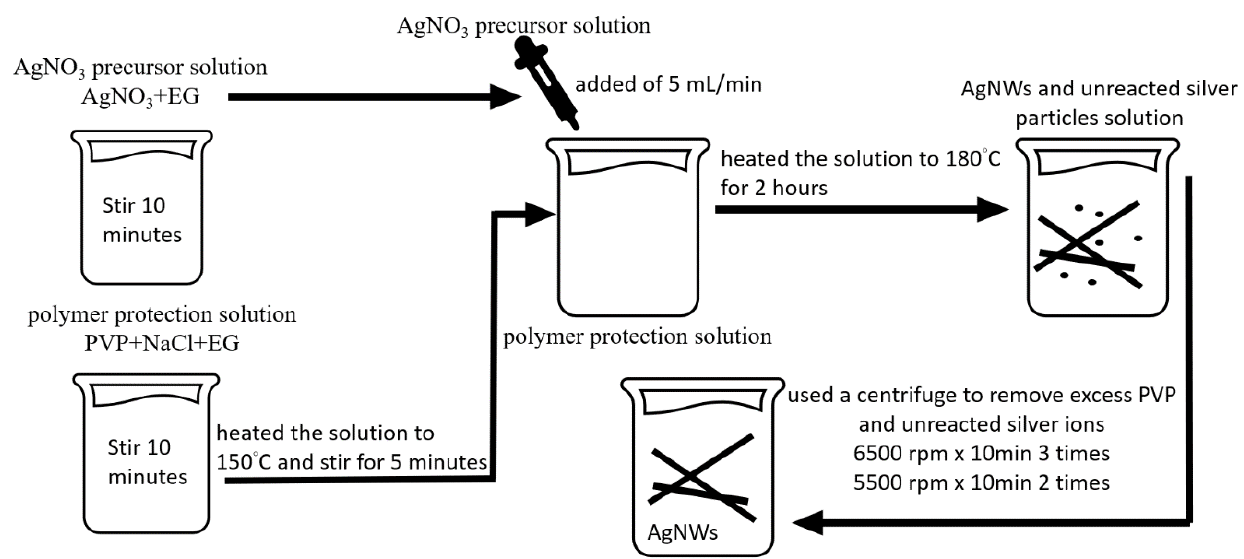
Figure 1. Schematic diagram of the manufacturing route of AgNWs prepared by polyol method.